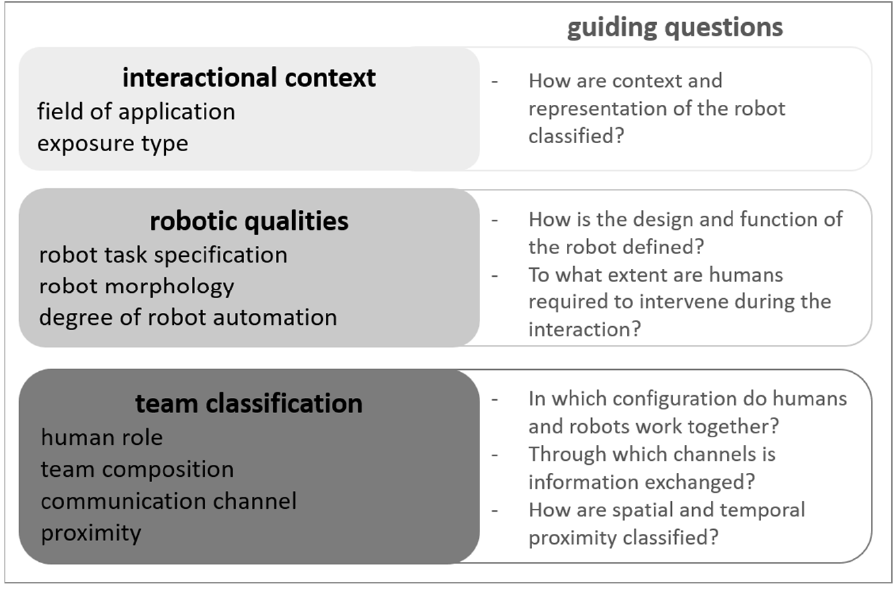
Figure 11. Taxonomy and guiding questions for HRI according Onnasch and Roesler [44].